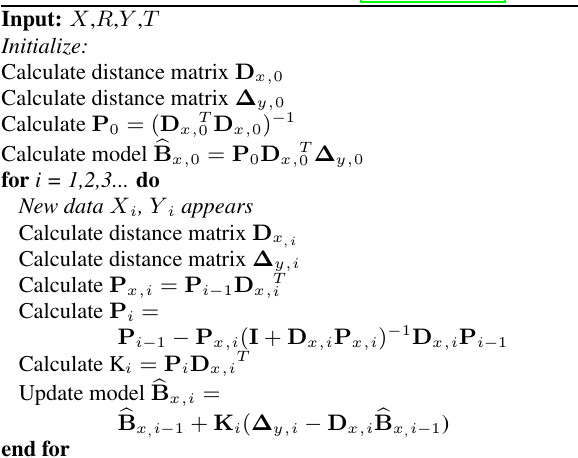
Algorithm 1: Recursive Least Squares (Romberg,